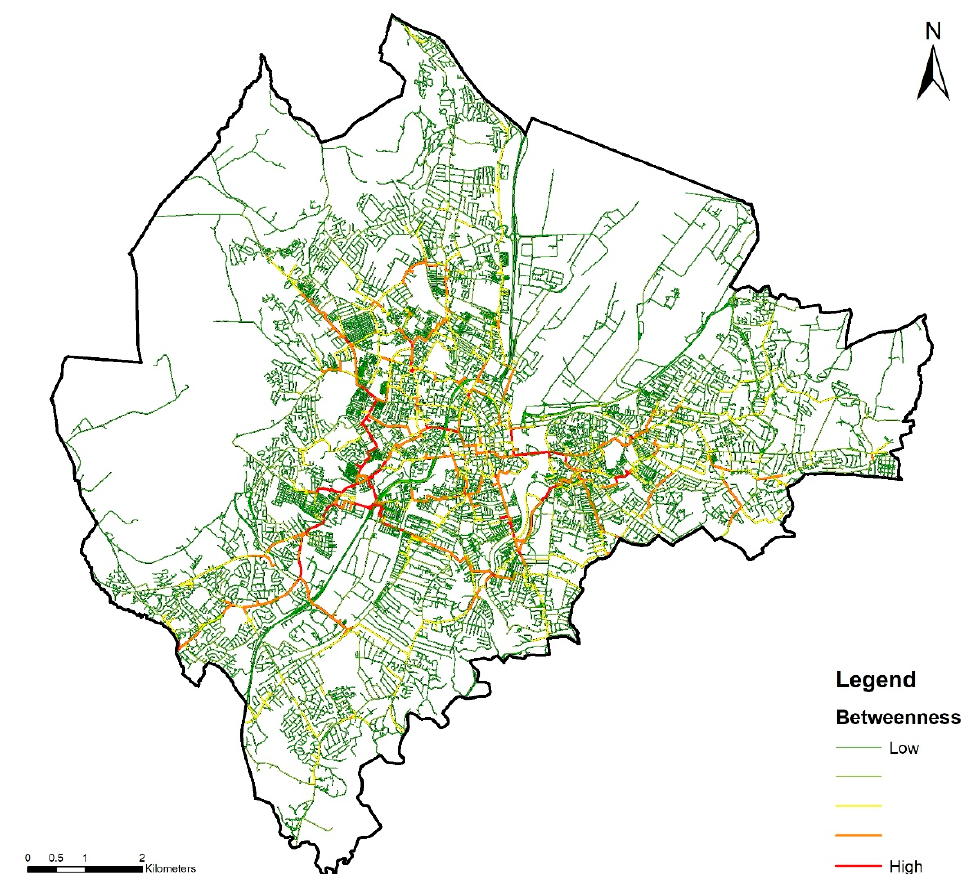
Figure 2. Map of the City of Belfast study area and the betweenness values of the road network .